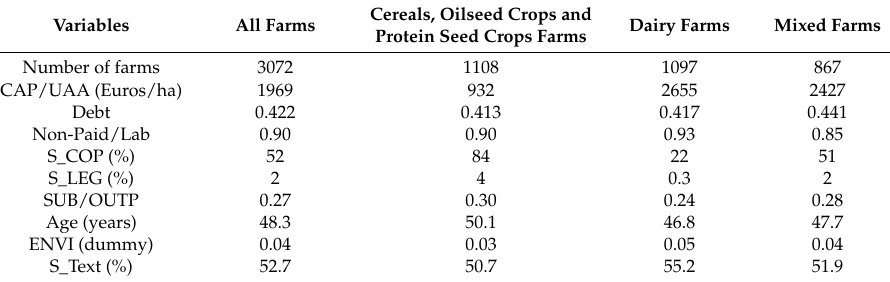
Table 4. Descriptive statistics of the determinants of slacks